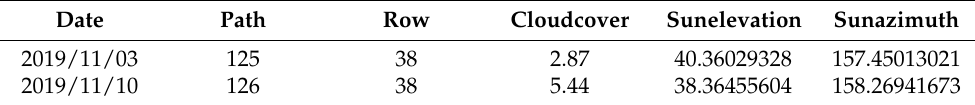
Table 1. The detailed data parameters of remote sensing images.